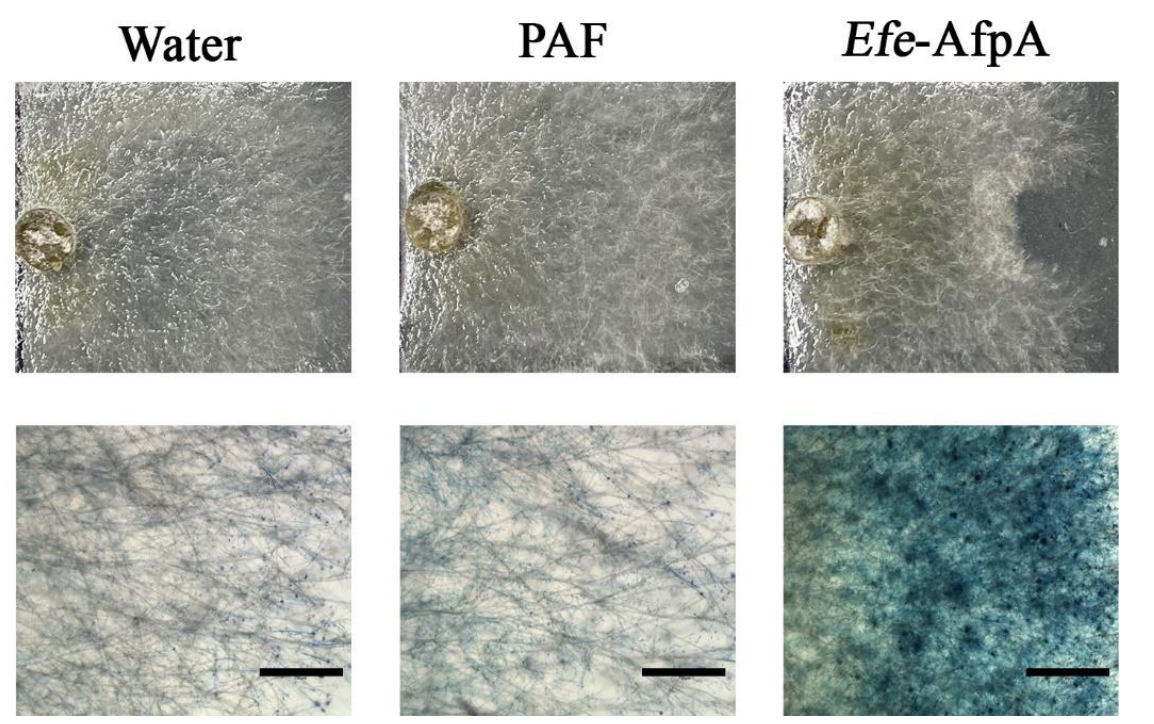
Figure 5. Comparison of the activity of Efe -AfpA expressed in Pe. chrysogenum with PAF, a similar antifungal protein from Pe. chrysogenum , against C. jacksonii in culture. In the upper panels ( A ) water (10 µ L), PAF (300 ng), or purified Efe- AfpA (300 ng), was placed on the right side of a plug of C. jacksonii . The lower panels ( B ) show the C. jacksonii hyphae from the upper panels treated with Evans blue. Bars in the lower panels are 750 μ m.